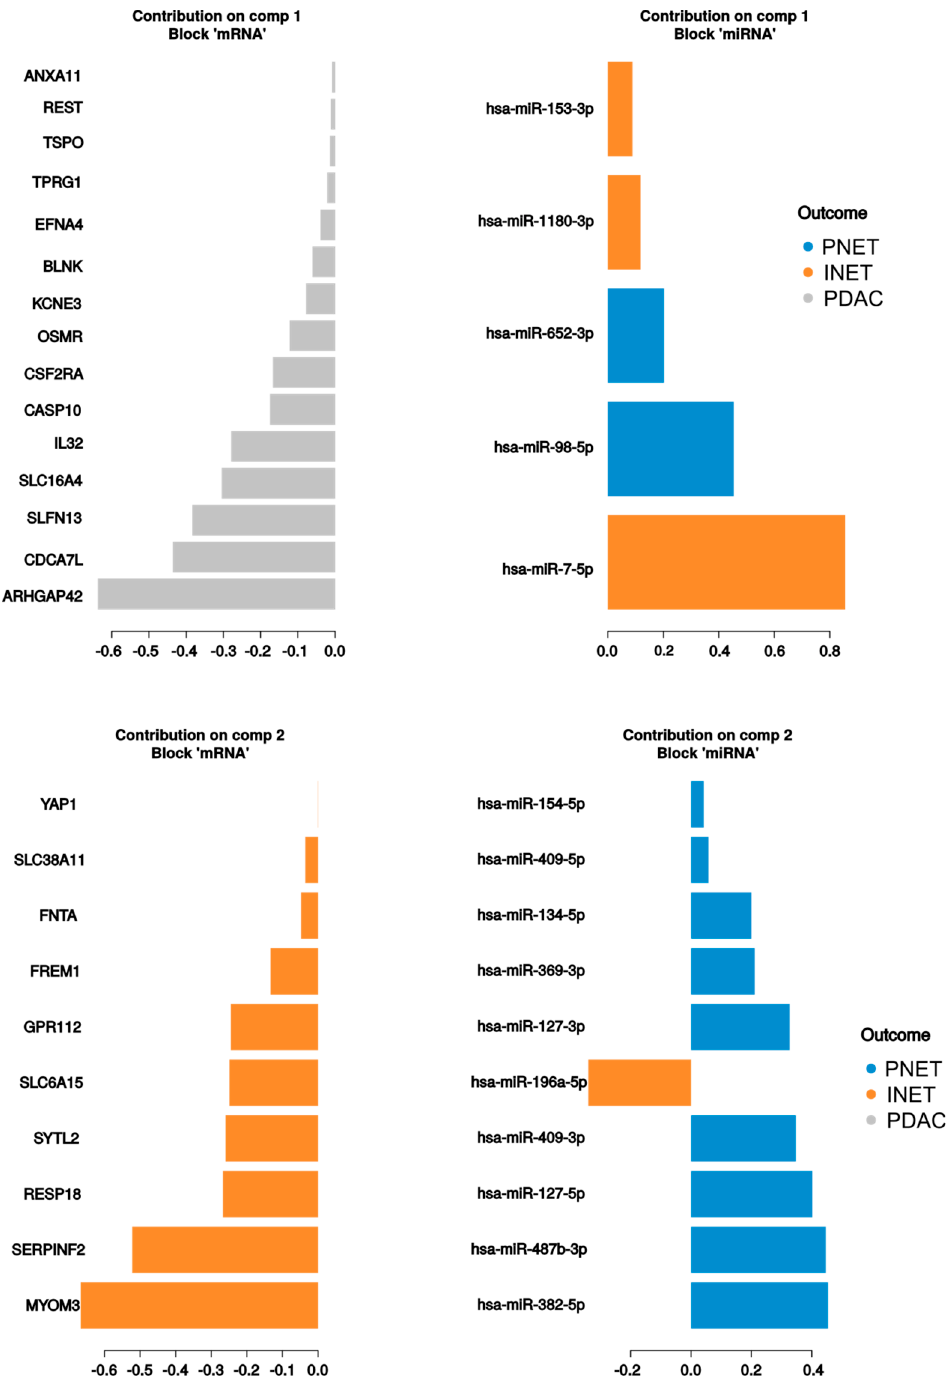
Figure 6. Main contributors to the first two components of the DIABLO PLS-DA model for miRNA and mRNA.